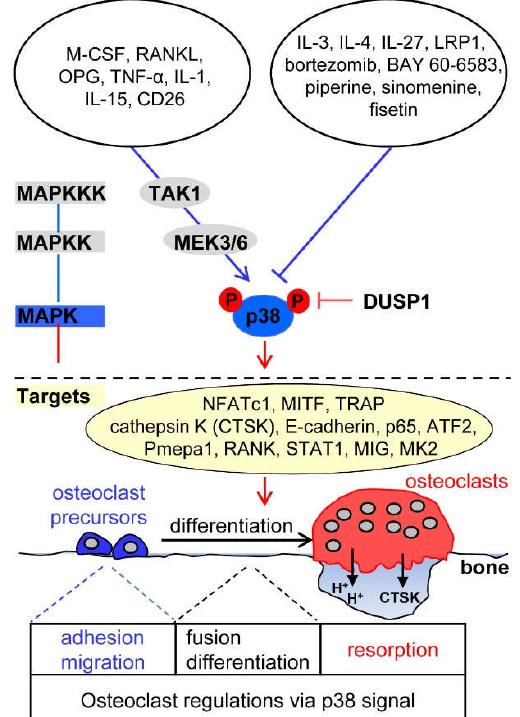
Figure 3. Osteoclastogenic signaling cascade controlled by upstream activators and inhibitors of p38 mitogen-activated protein kinases (MAPK). The presented molecules are described in the part of “p38 signaling in osteoclasts”. Arrows indicate activation of the signaling pathways while T bars indicate inhibition of the signaling pathways.